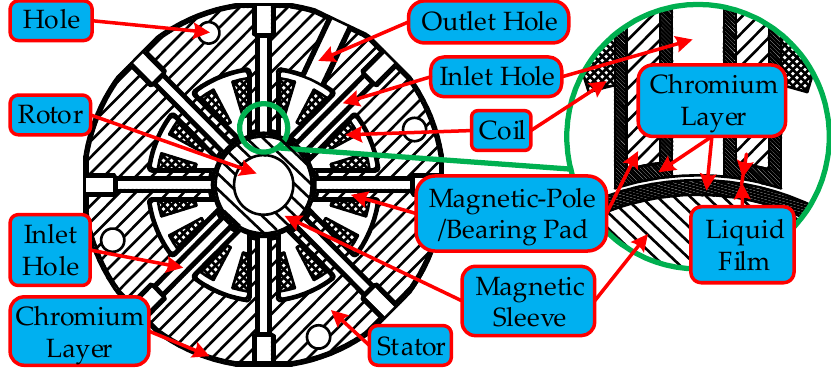
Figure 3. Radial Journal Unit of MLDSB.